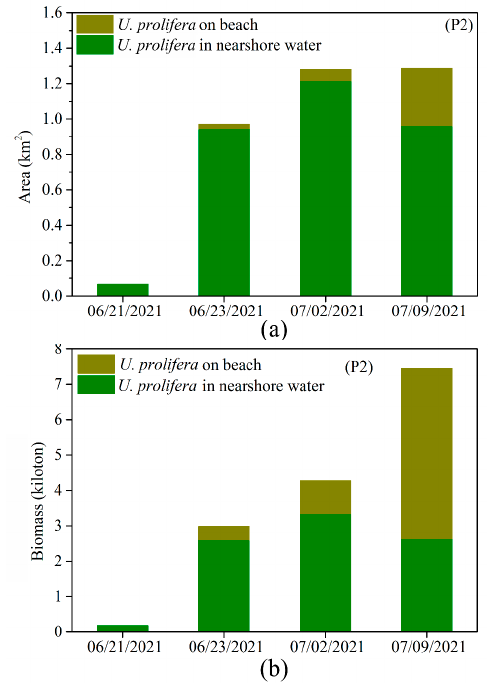
Figure 9. The statistical results for coverage area and biomass of U. prolifera in the P2 area. ( a ) The statistical results for the coverage area of U. prolifera on the beach and in nearshore water; ( b ) the statistical results for the biomass of U. prolifera on the beach and in nearshore